Question: Describe this figure in one sentence.
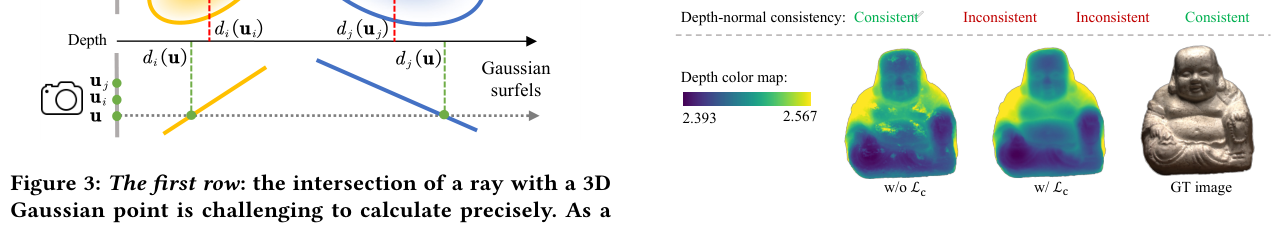
Answer: Depth-normal consistency. Top: The consistency of surfel depth and normal during optimization. Bottom: Ren- dered depth maps with and without consistency loss, along- side the reference image.